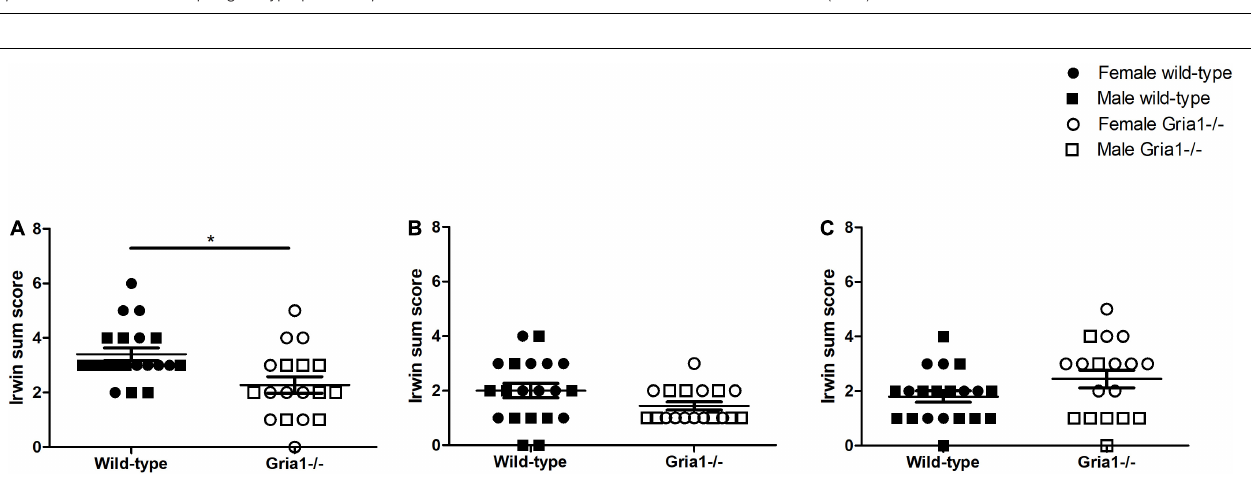
Frontiers in Behavioral Neuroscience |